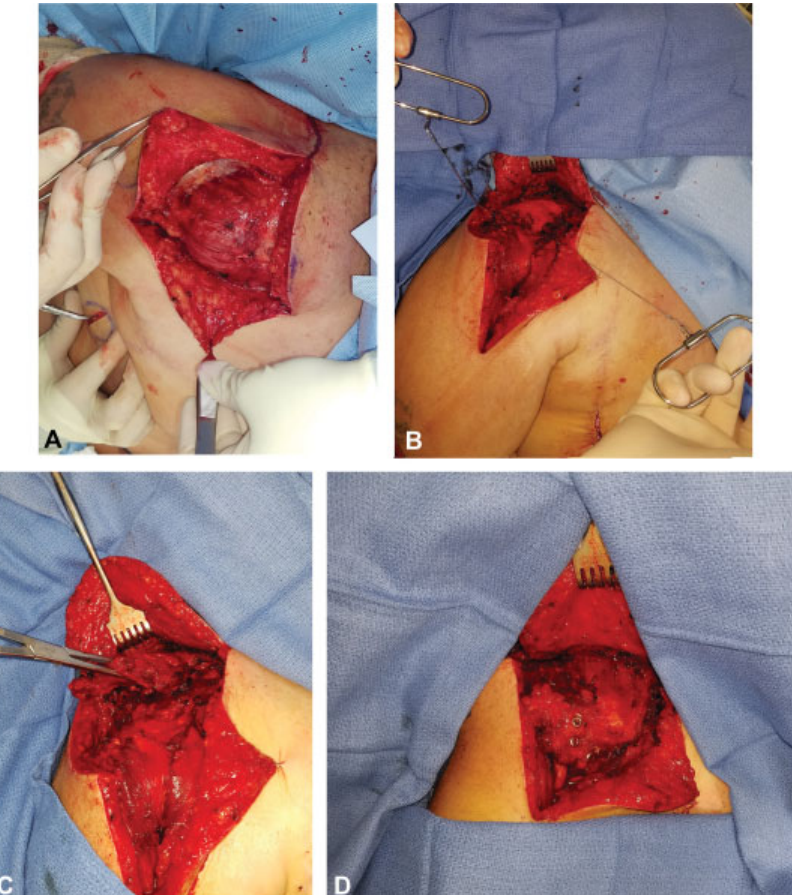
Fig. 1 Intraoperative photographs depicting surgical technique. A U-shaped incision with a vertical extension is made surrounding the acromial joint and over the humerus inferiorly ( A ). Using a Gigli saw, a transverse ostectomy of the acromioclavicular joint is performed, maintaining the soft tissue over the anterior acromion process ( B ). The trapezius is elevated off the scapula and the clavicle with care to avoid injury of the spinal accessory nerve ( C ). Three cannulatedscrews are placedthrough theacromion process to mobilize itanterolaterally andas far distally aspossible on the humerus while the arm is in an abducted and slightly rotated position ( D ).